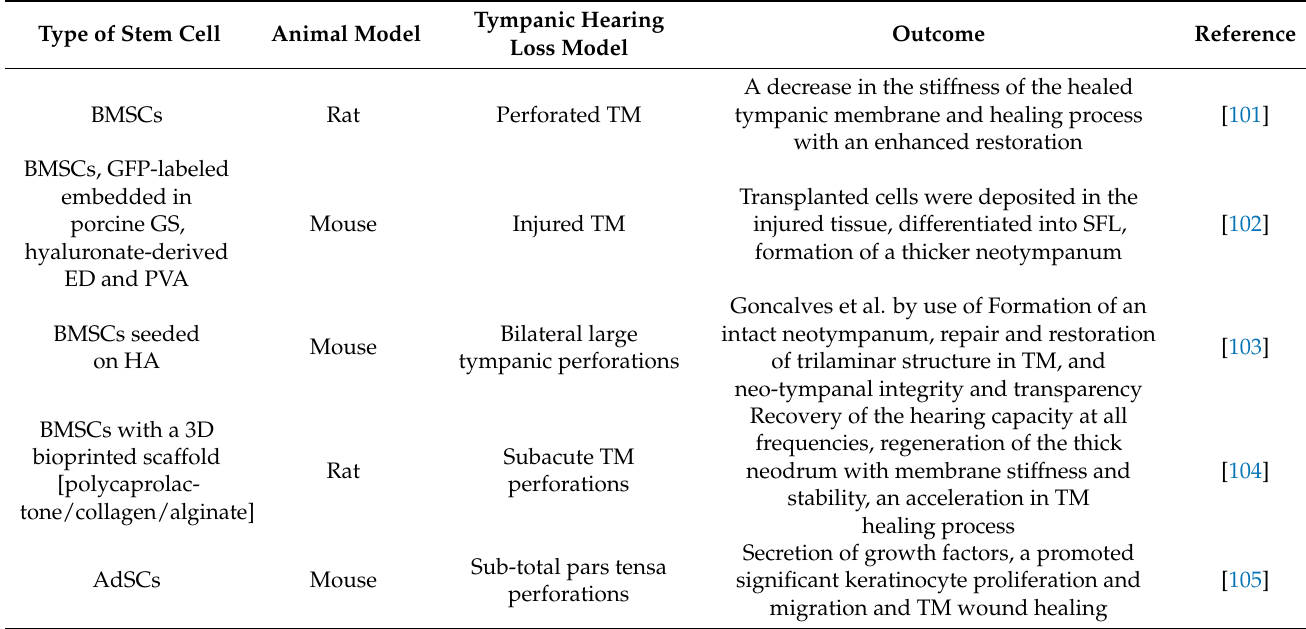
Table 2. In vivo studies of tympanic membrane related hearing